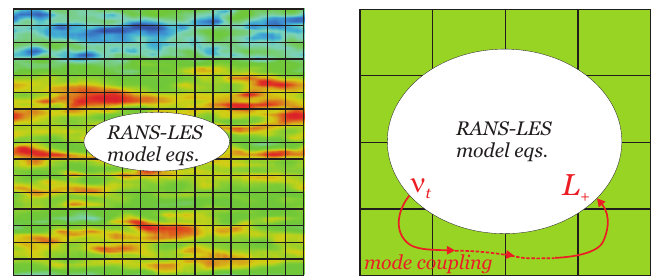
Figure 3. An illustration of the interplay of modeled motion (indicated by ellipses of different size) and resolved motion (indicated by blue and red turbulent fluctuations). The mode coupling mechanism is illustrated by red lines on the right. The grid is illustrated by vertical and horizontal black lines. On the left, there is a case with high flow resolution, on the right there is a case with almost no flow